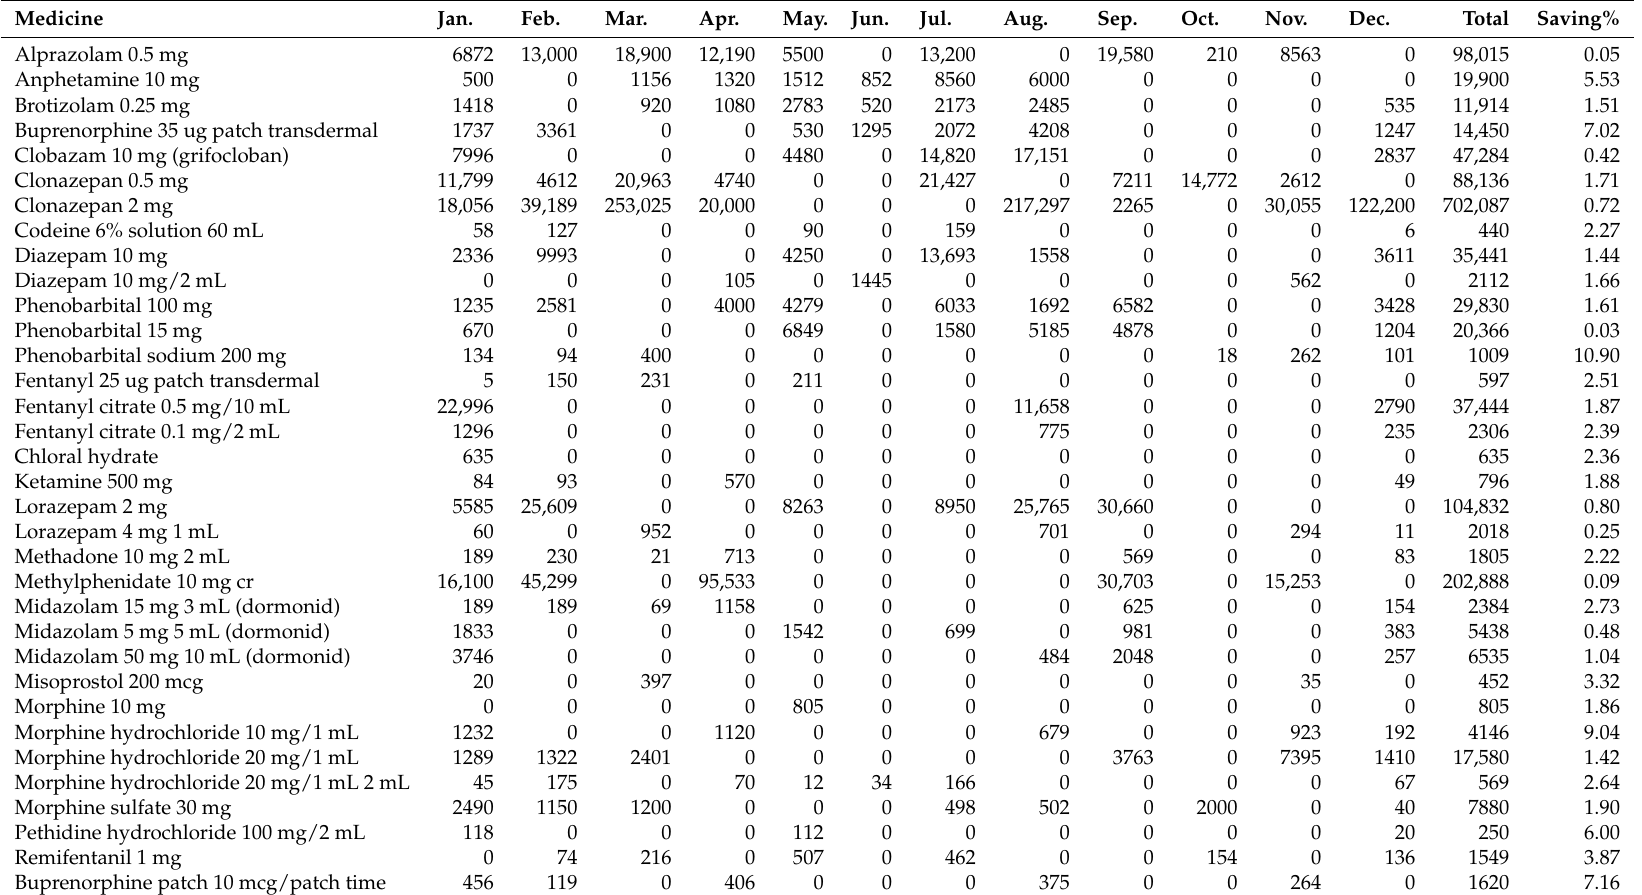
Table A1. Monthly purchase volume (in units) induced by SM for the 34 medication of the controlled medication pharmacy of the HRT during